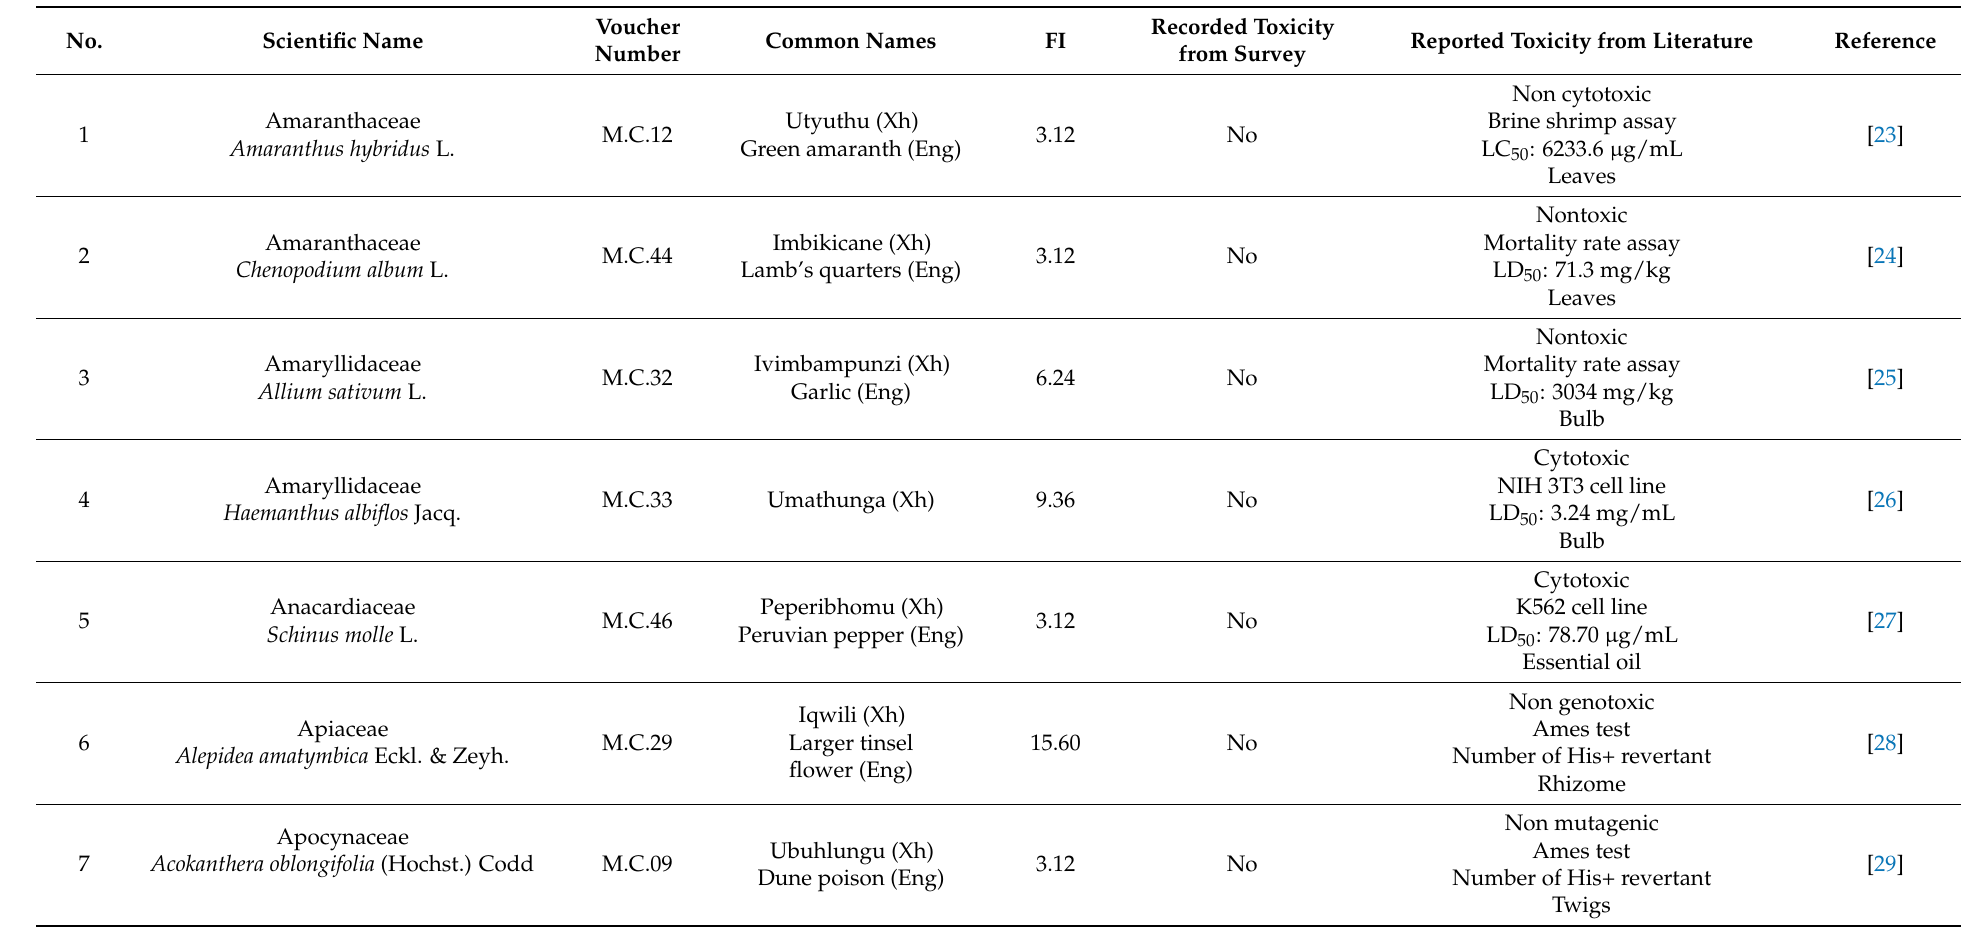
Table 1. Toxicity status for plants with cosmeceutical relevance used by Xhosa communities in the Raymond Mhlaba Municipality, Amathole district, Eastern Cape